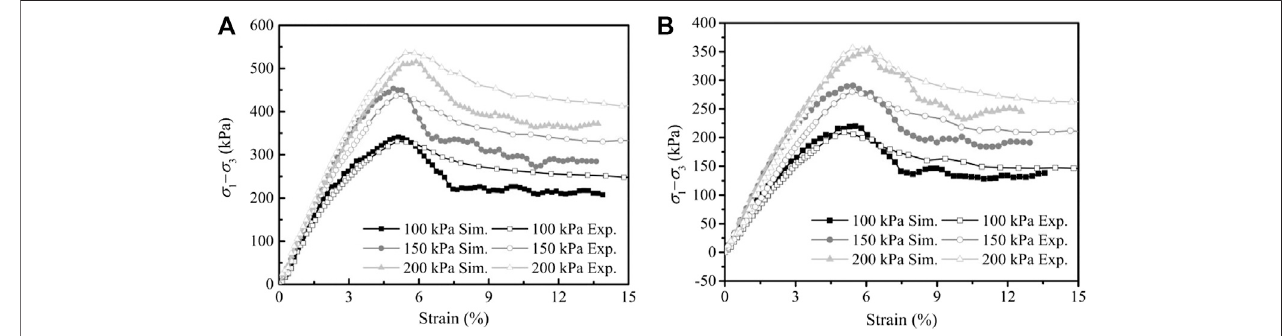
FIGURE 2 | Stress – strain curves of the simulated and experimental results. (A) Before FT. (B) After FT. Note: “ After FT ” means the soil experienced eight times of freeze – thaw action, of which the damage was the most serious (Fu, 2017).